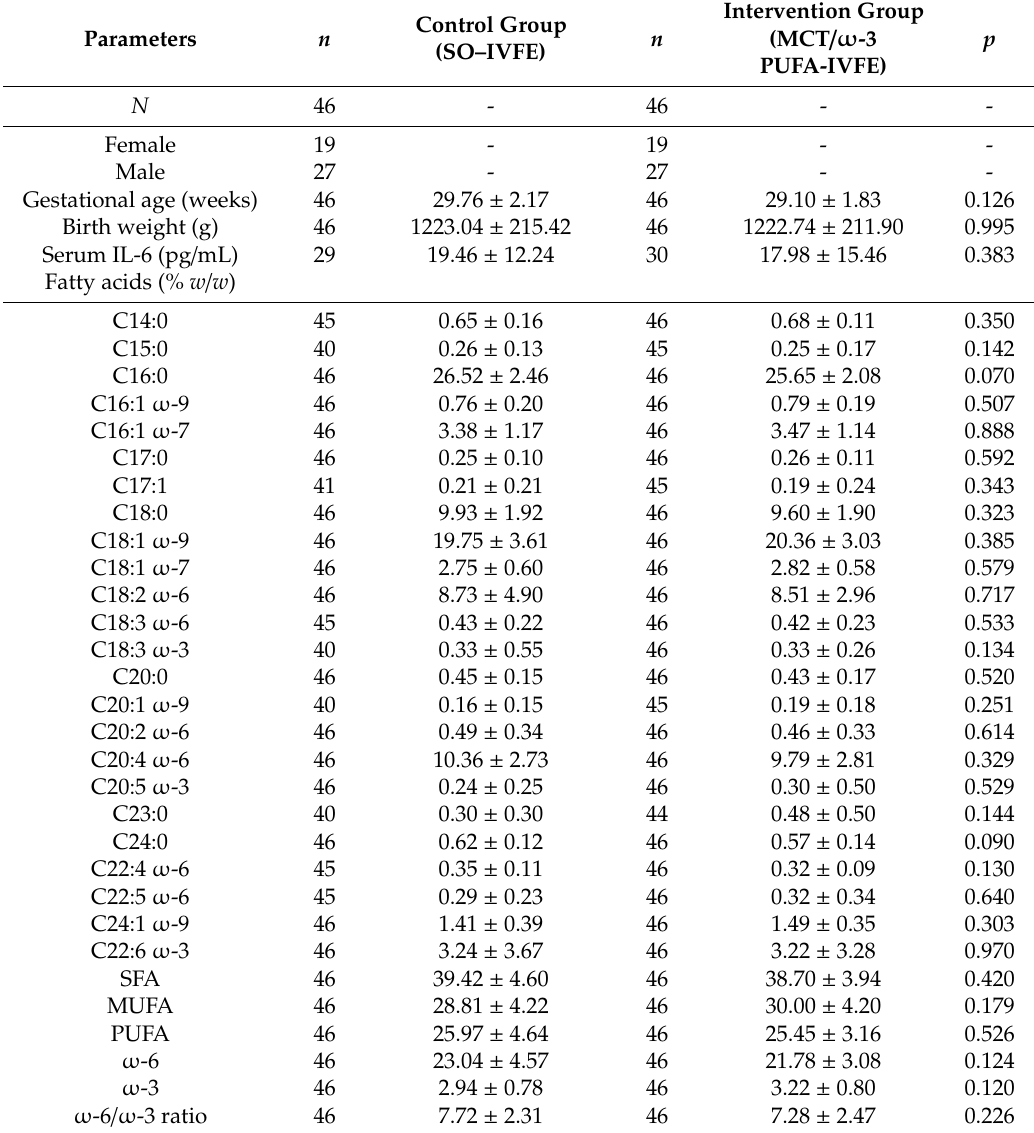
Table 1. Group characteristics at baseline (day